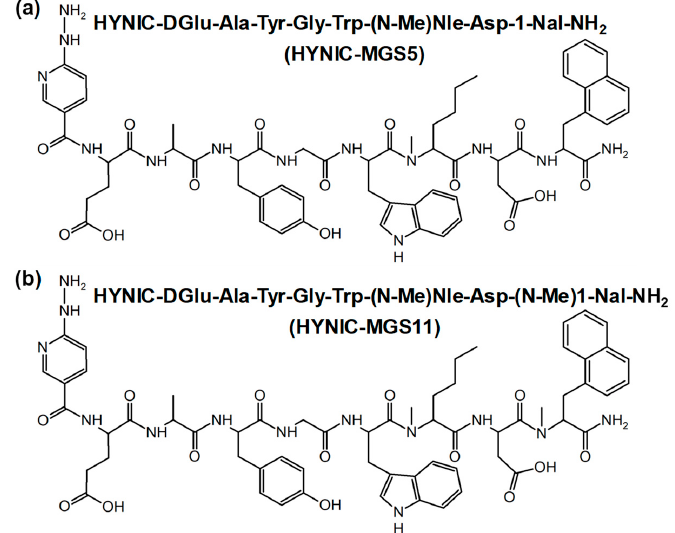
Figure 1. Amino acid sequence and chemical structure of ( a ) HYNIC-MGS5 and ( b ) HYNIC-MGS11.